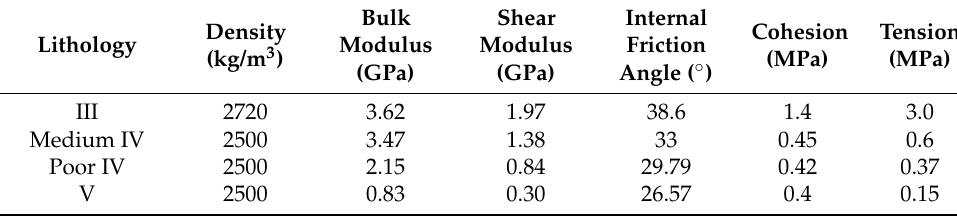
Table 3. The parameters of the adverse geological structure zone with different